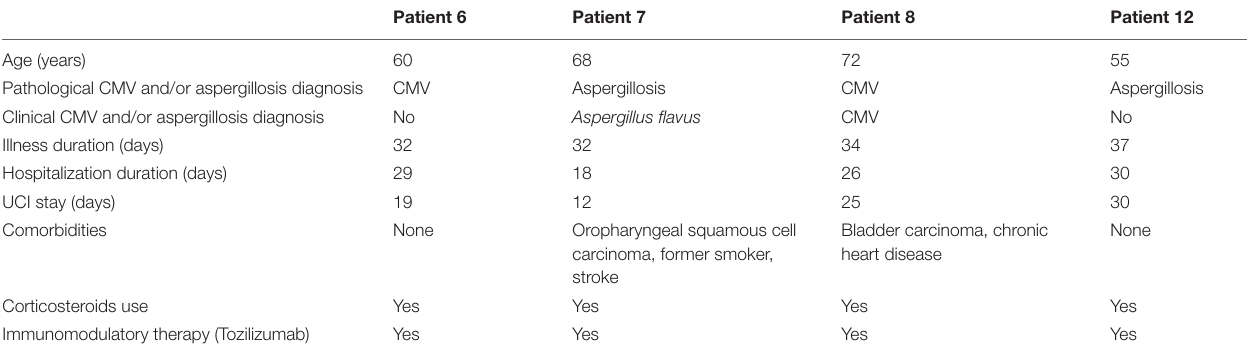
TABLE 3 | Features of patients with a cytomegalovirus (CMV) or aspergillosis diagnosis.